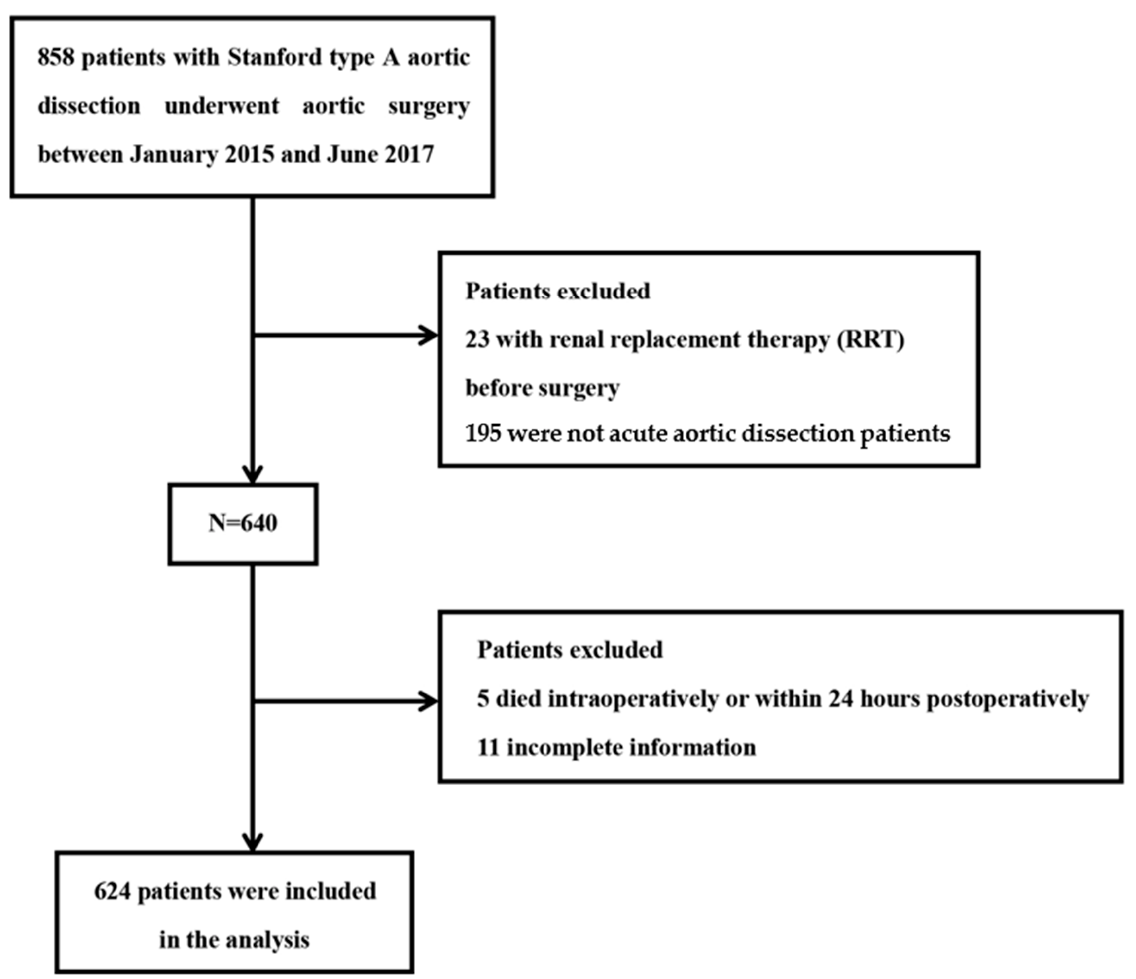
Figure 1. Flow diagram of the screening and enrolment of study patients. After exclusion criteria were applied, 624 consecutive patients were included in this